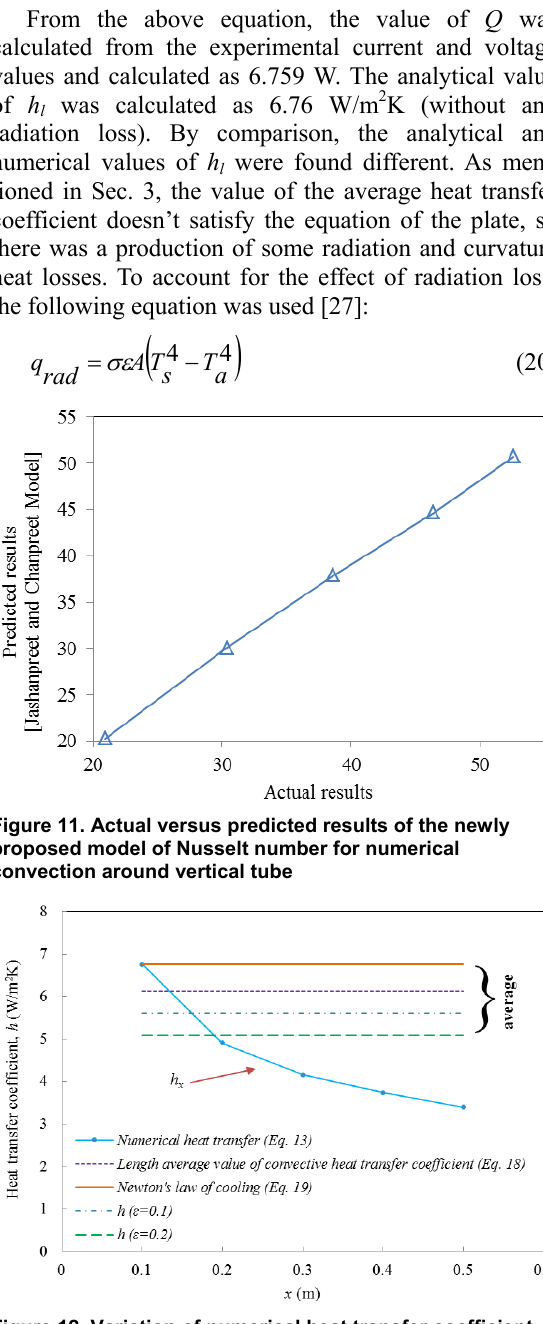
Figure 12. Variation of numerical heat transfer coefficient with respect to constant analytical heat transfer coefficient